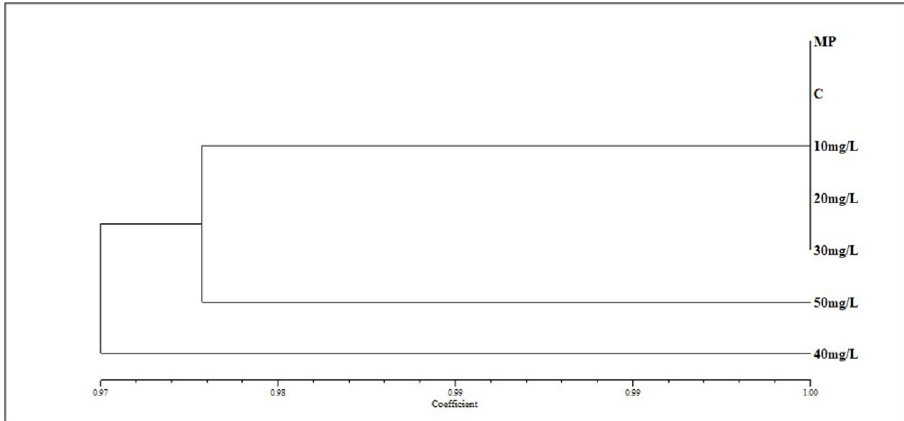
Figure 8. Dendrogram based on UPGMA analysis presenting the relationships between M. oblongifolia shoots plants treated with AgNPs (C, 10, 20, 30, 40 and 50 mg/L); MP = Mother plant. In the case of ZnO NPs treatments, the values of uniformity ranged between 0.98 and 1.00 ( S 4 ). The highest similarity value (1.00) was observed in all ZnO NPs-treated plants compared to the MP, whereas the shoots treated with 20 mg/L demonstrated the lowest value of similarity (0.98). The dendrogram generated for the ISSR marker showed that with the exception of 5 mg/L of ZnO NPs, the rest of the ZnO NPs-treated plants were 100% identical to the MP. The dendrograms generated through the UPGMA analysis re- vealed a 98% similarity amongst the ZnO NPs treatment regenerates and the mother plant (Figure 9).